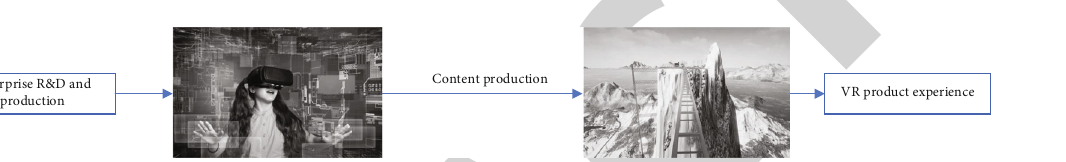
Figure 5: Data dimensionless step diagram.